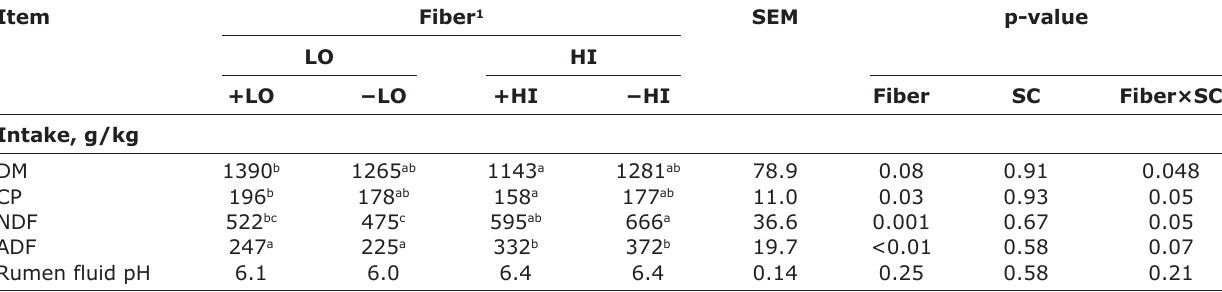
Table-2: Effect of SC supplementation in Awassi female lambs fed with LO- and HI-fiber diets on nutrient intakes (g/kg DM) and rumen fluid pH. Item